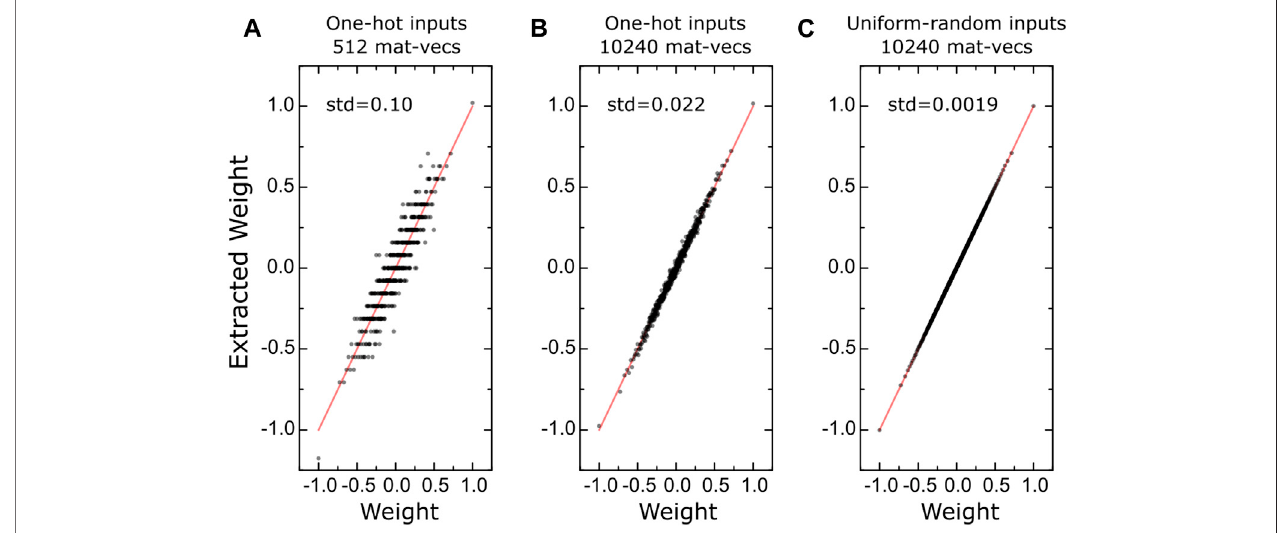
FIGURE6| ( A – C )Correlationbetweenthegroundtruthweightsandtheextractedvaluesusingdifferentinputformsandnumberofmat-vecsforasimulated512 × 512 tile. Red lines are guides to the eye showing perfect correlation.